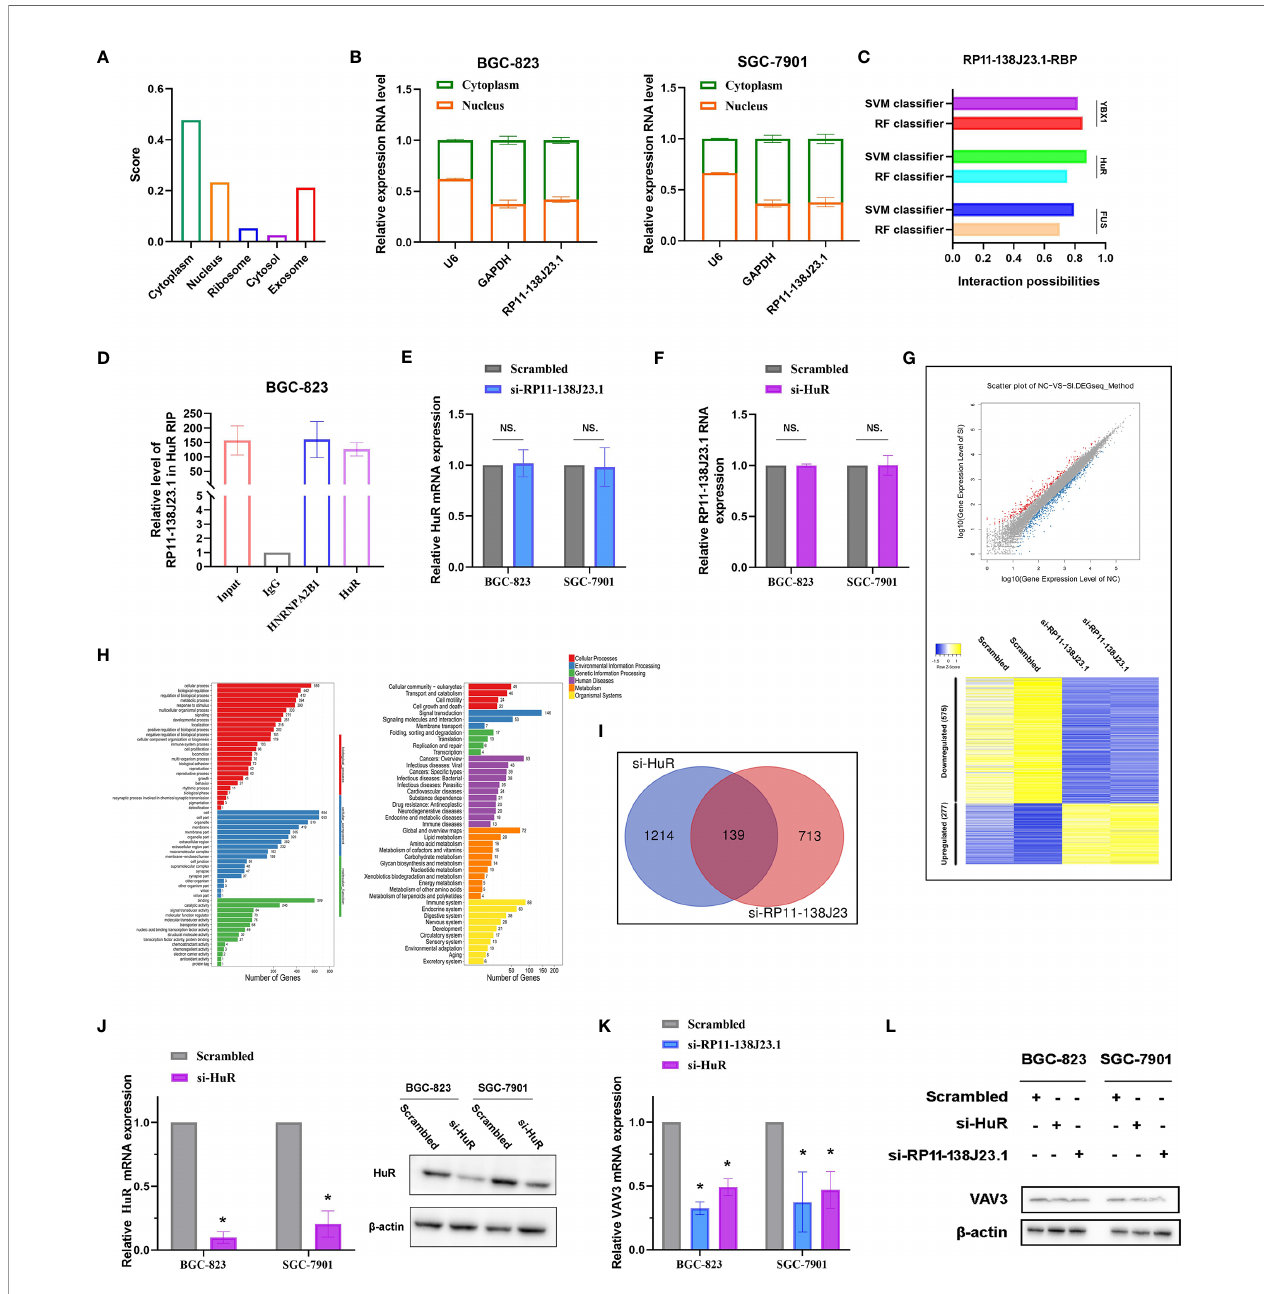
FIGURE 6 | RP11-138J23.1 regulated VAV3 expression level via interacting with HuR. (A) The subcellular localization of RP11-138J23.1 via prediction website (http://www.csbio.sjtu.edu.cn/bioinf/lncLocator/). (B) RP11-138J23.1 expression levels in different subcellular fractions in BGC-823 and SGC-7901. U6 was used as a nucleus marker, and GAPDH was a cytosol marker. (C) The interaction probabilities between HuR and RP11-138J23.1 were predicted by the RNA-Protein Interaction Prediction (RPISeq) website. (D) RIP with rabbit monoclonal anti-HuR and preimmune IgG from BGC-823 cell extracts. RNA levels in immunoprecipitates were detected by qPCR. Expression levels of RP11-138J23.1 RNA are presented as fold enrichment in HuR relative to IgG immunoprecipitates. (E) qRT-PCR analysis of HuR mRNA expression level in BGC-823 and SGC-7901 after RP11-138J23.1 knockdown. (F) qRT-PCR analysis of RP11-138J23.1 RNA expression level in BGC-823 and SGC-7901 after HuR knockdown. (G) RNA transcriptome sequencing analysis was performed to analyze gene expression pro fi ling in BGC- 823 cells following RP11-138J23.1 knockdown. Volcano plot and heatmap showed all the differently expressed genes. (H) Go cellular component and KEGG pathway analysis for all genes with altered expressions between the negative control group and RP11-138J23.1 knockdown group cells in vitro . (I) In total, 139 transcripts were altered simultaneously in si-RP11-138J23.1-treated cells and si-HuR-treated cells (fold change >2, p < 0.05). (J) The HuR mRNA and protein expression level in BGC-823 and SGC-7901 transfect with siRNAs. (K) The VAV3 mRNA expression level in BGC-823 and SGC-7901 transfect with si-RP11-138J23.1 and si-HuR. (L) The VAV3 protein expression level in BGC-823 and SGC-7901 transfect with si-RP11-138J23.1 and si-HuR. The data represent the mean ± SD from three independent experiments. * p < 0.05. NS, Not Signi fi